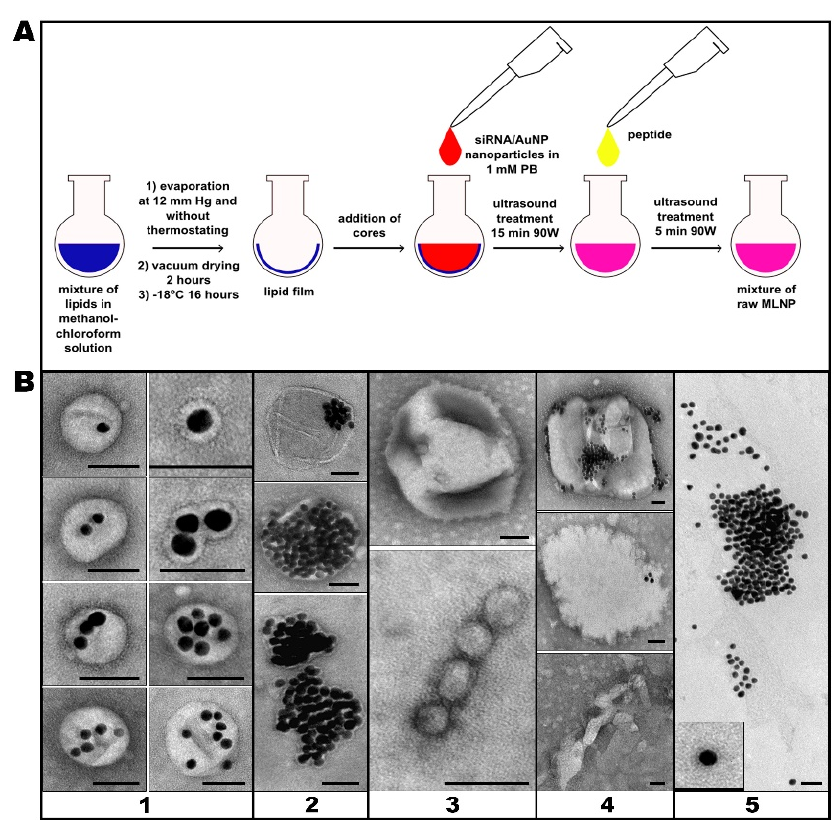
Figure 3. ( A ) The scheme of MLNC formation after the application of a suspension of the core na- noparticles to the lipid film and sonication. ( B ) Morphology of the particles in the MLNC prepara- tions. Panel 1: different subtypes of a “target MLNC” containing 1 to 10 electron-dense core nano- particles; Panel 2: aggregates of the core nanoparticles surrounded by a thin lipid envelope; Panel 3: empty lipid particles; Panel 4: fragments of the lipid film with adhered core nanoparticles; Panel 5: “naked” core nanoparticles. The scale bars correspond to 50 nm. Negative staining with uranyl acetate followed by TEM.